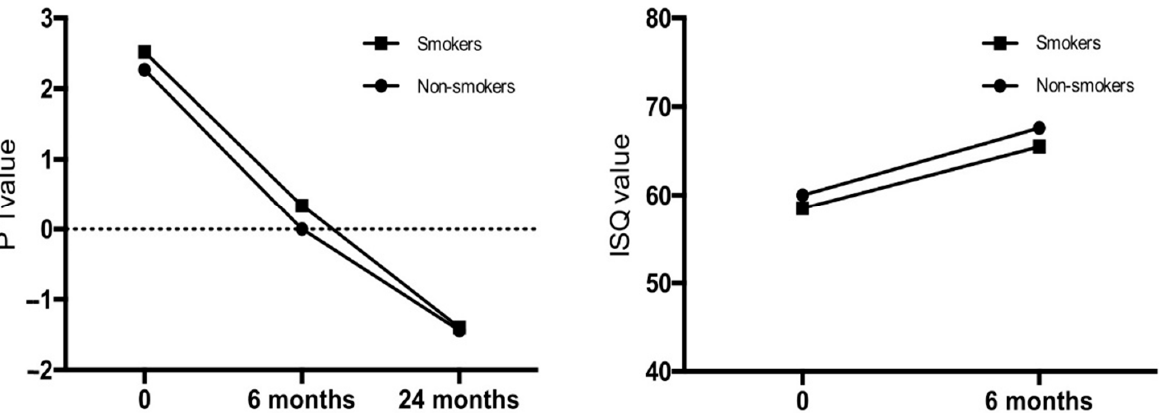
Figure 1. Implant stability in the aesthetic area of smokers and non-smokers, following immediate implantations in maxilla. Table 3. Implant stability and bone atrophy in the aesthetic area of smokers and non-smokers, following immediate im- plantations in maxilla (ISQ—mean Implant Stability Quotient; PT—periotest measurements).